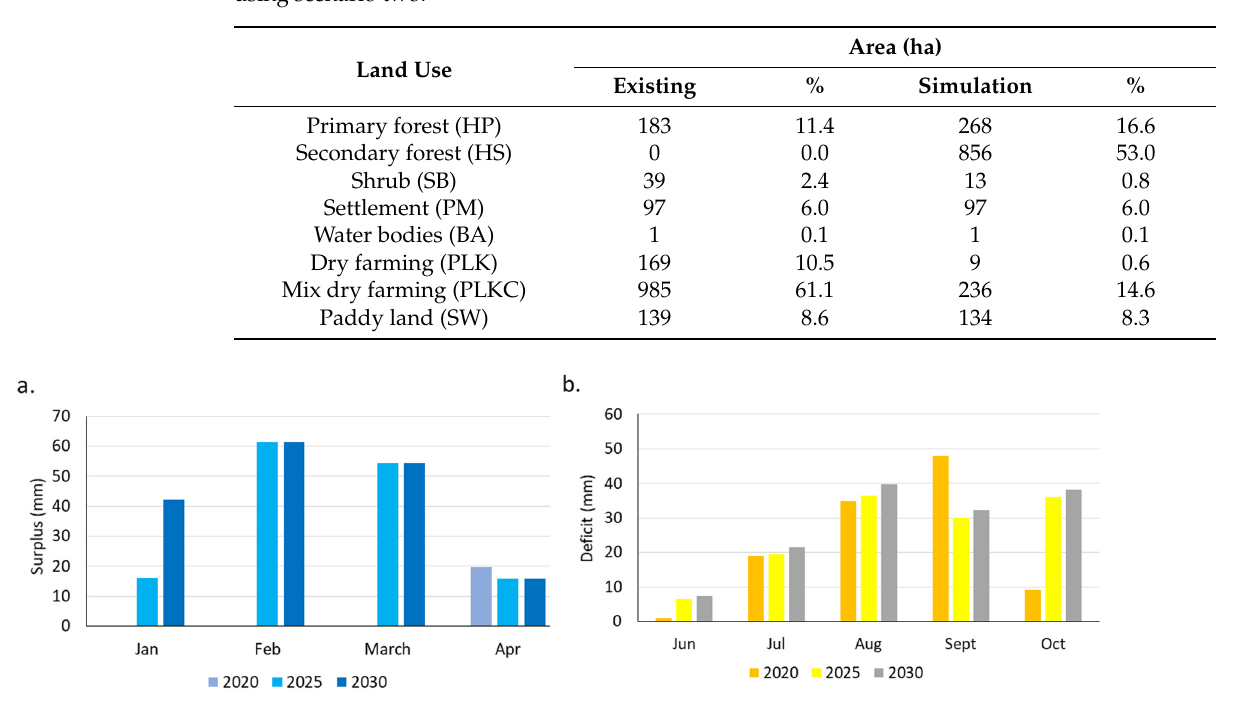
Figure 11. Changes in the water surplus ( a ) and deficit ( b ) in 2025 and 2030 based on the simulation with scenario two in the Dodokan Watershed.